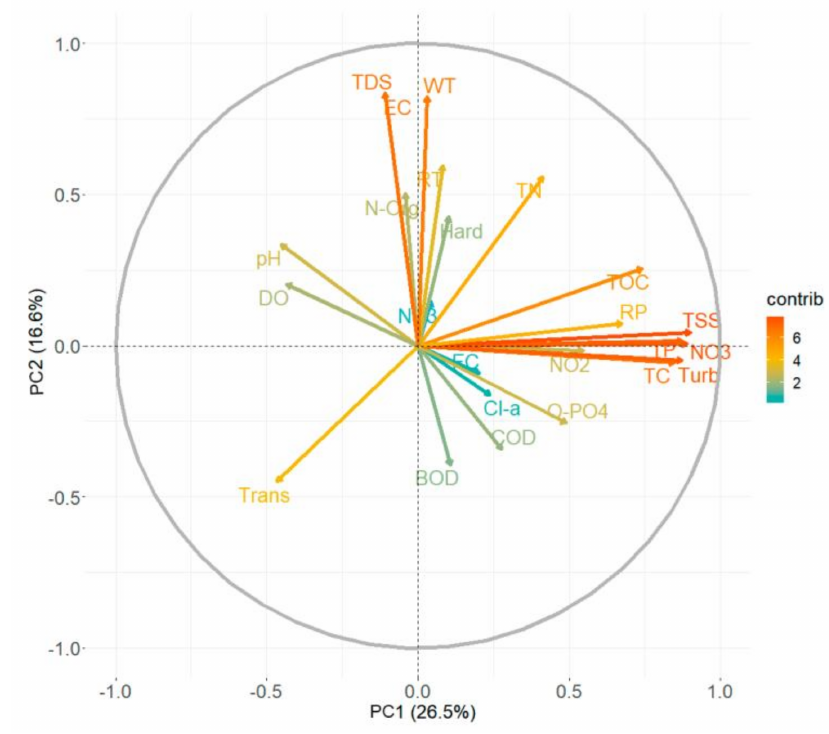
Figure 8. Principal Component Analysis diagram of water quality parameters.